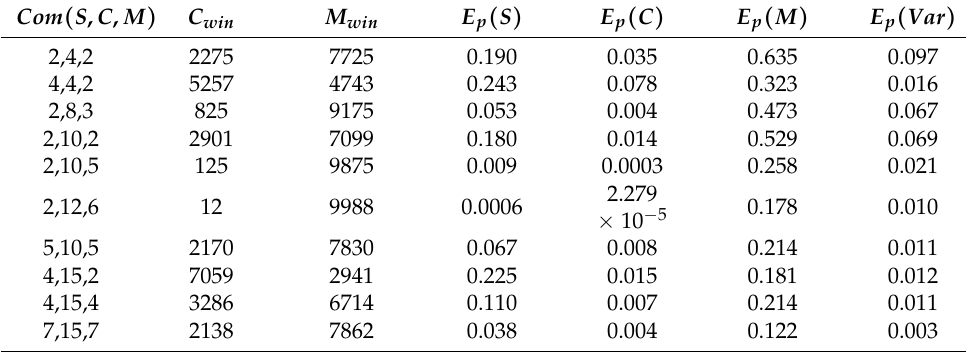
Table 3. Potential energy of Mafia characters based on various